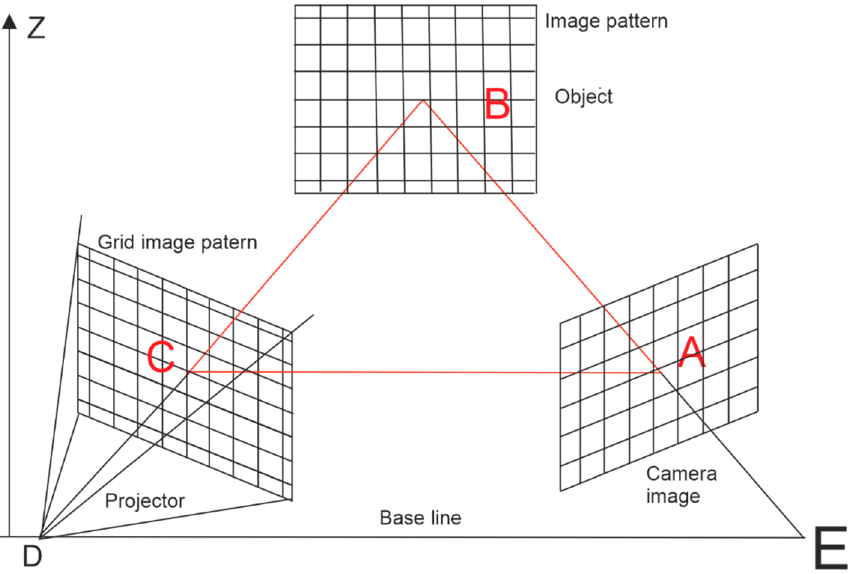
Figure 5. A schematic diagram of the principle of the digital image projection method